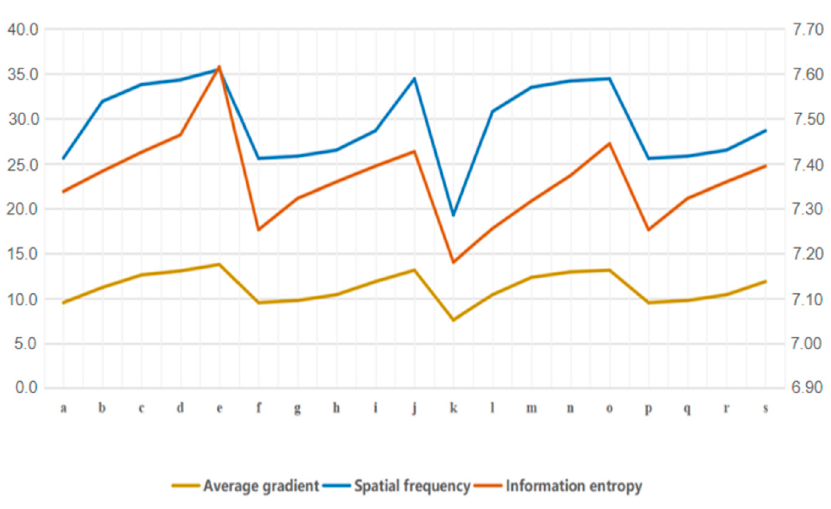
Figure 7. Line chart of the fusion coefficients analysis